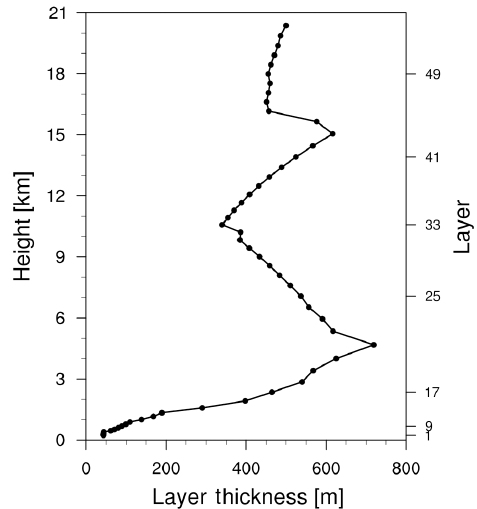
Figure 2. The thickness of each vertical layer in the simulations (54 layers in